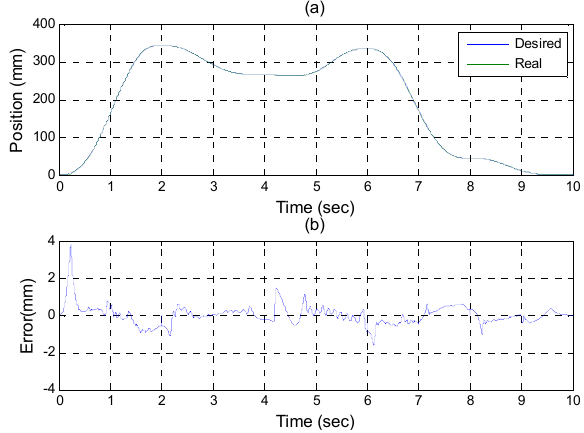
Figure 22. Experiments for B axis cylinder ( a ) tracking responses ( b ) tracking errors.